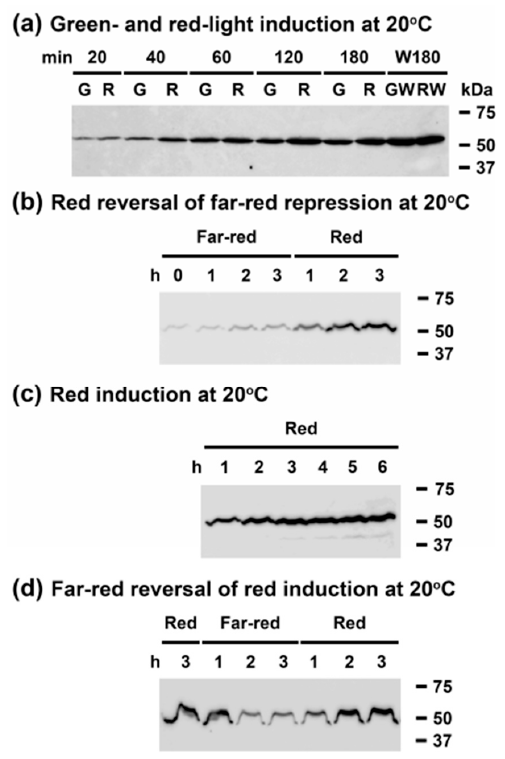
Figure 6. Far-red light reverses red light-induced CrhR protein accumulation. Wild type Synechocystis cells were grown to mid-log phase at 30 ◦ C and the effect of varying green, red and far-red light quality on CrhR induction was analyzed in conjunction with temperature downshift by Western blotting. ( a ) Effect of green and red light on low temperature induction. Synechocystis cells grown at 30 ◦ C under white light conditions were transferred to 20 ◦ C in either green (G) or red (R) light and sampled for 3 h at indicated time points. Cells were subsequently transferred to white light for 3 h (W180; GW, RW) to achieve maximal CrhR accumulation. Protein derived from green (G)- or red (R)-light treated cultures are displayed in adjacent lanes to aid visualization of the effects. ( b ) Red reversal of far-red repression. Synechocystis cells grown at 30 ◦ C under white light conditions (T = 0) were transferred to 20 ◦ C in far-red light and sampled for 3 h at indicated time points (Far-red 1, 2, 3). Cells were subsequently transferred to red light for 3 h (Red 1, 2, 3). ( c ) Effect of red light on low temperature induction. As a control for red light induction kinetics, Synechocystis cells grown at 30 ◦ C under white light conditions were transferred to 20 ◦ C in red light and sampled for 6 h (Red 1, 2, 3, 4, 5, 6). Results shown in panels B and C were performed concurrently and subjected to Western blotting on the same blot and thus, the T0 time point shown in panel B also corresponds to T0 for panel C. ( d ) Far-red reversal of red induction. Synechocystis cells grown at 30 ◦ C under white light conditions were transferred to 20 ◦ C in red light for 3 h to induce maximum CrhR accumulation (Red 3). Cells were subsequently transferred to far-red light for 3 h (Far-red 1, 2, 3) and then returned to red light for 3 h (Red 1, 2,